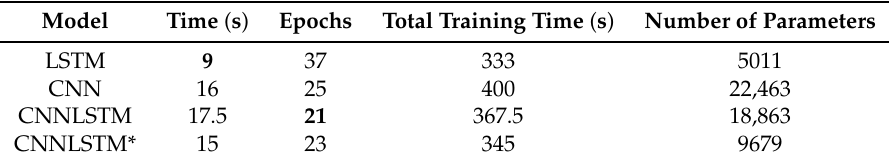
Table 3. The training time and number of parameters of the models.